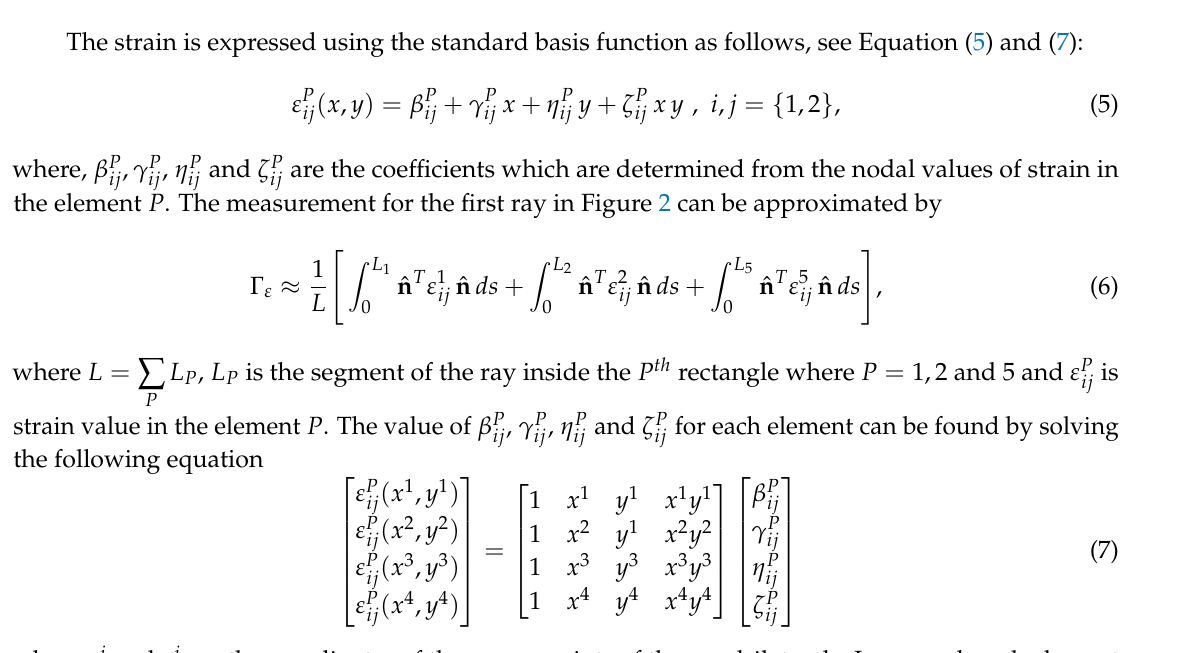
Figure 2. Finite element